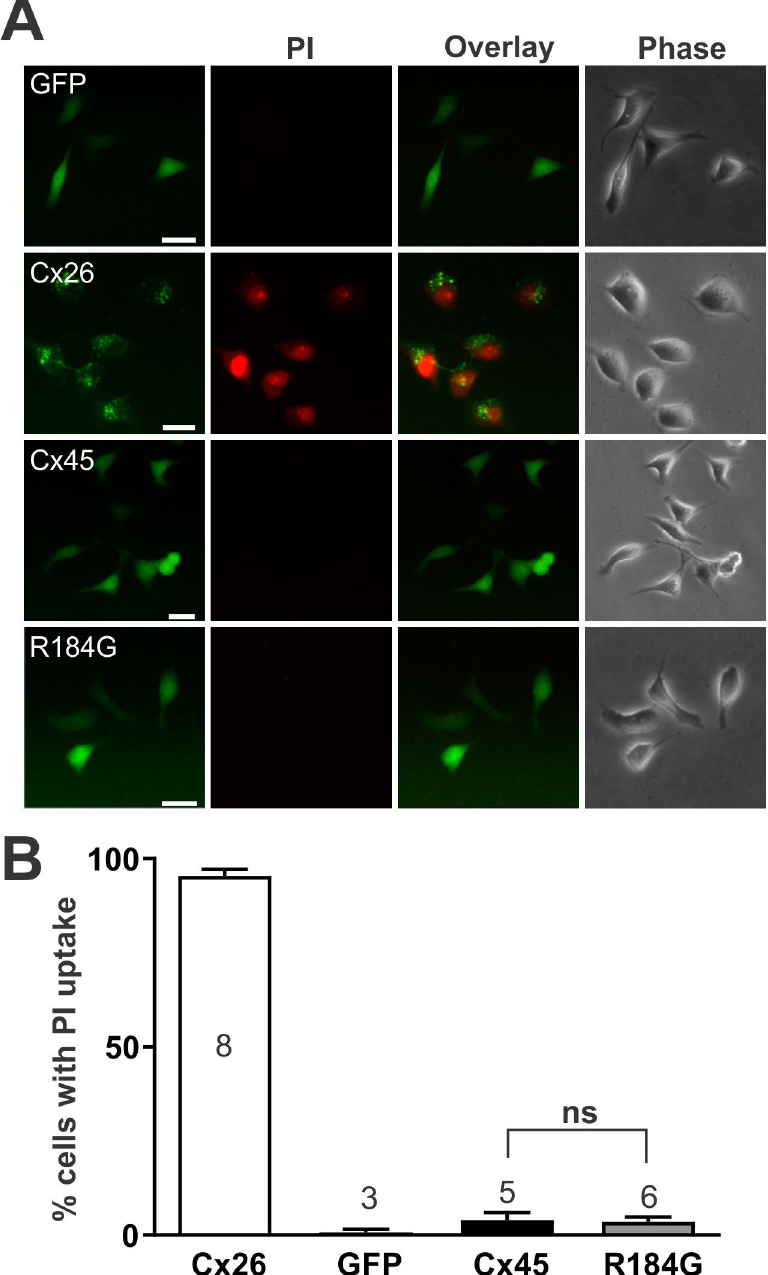
Figure 5. PI uptake in HeLa cells expressing Cx45 R184G was not different from that in wildtype Cx45 expressing cells. ( A ) Representative propidium iodide (PI) uptake fluorescent images of HeLa cells expressing GFP alone (negative control), Cx26-GFP (positive control), wildtype Cx45, and Cx45 R184G. An uptake of little PI was seen for either wild-type Cx45 or Cx45 R184G-expressing cells. The first column exhibits the fluorescence of GFP. The second column exhibits cells with the uptake of PI in red. The third column is an overlay, a combination of red fluorescence and green fluores- cence. The fourth column exhibits the phase contrast images of HeLa cells. The white scale bar in the first column images represents 20 µm. ( B ) Bar graphs outlining PI uptake percentage of the HeLa cells that expressed wild-type Cx26-GFP (positive control), GFP (negative control), Cx45, and Cx45 R184G. There was no significant difference (ns) in PI uptake in cells expressing R184G and those expressing wild-type Cx45. N noted above or in a bar is the number of transfections.